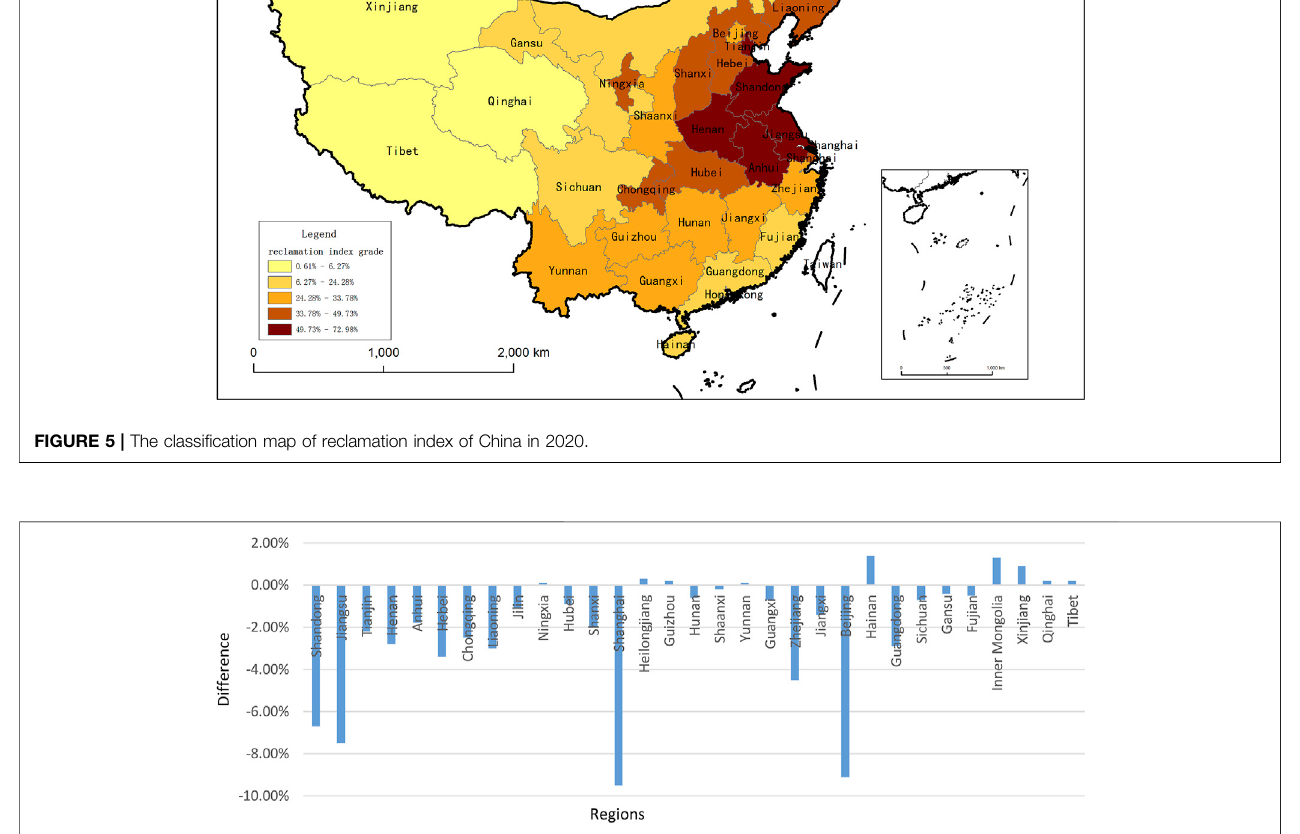
FIGURE 6 | The difference of reclamation index of 31 regions in China during 2010 – 2020.